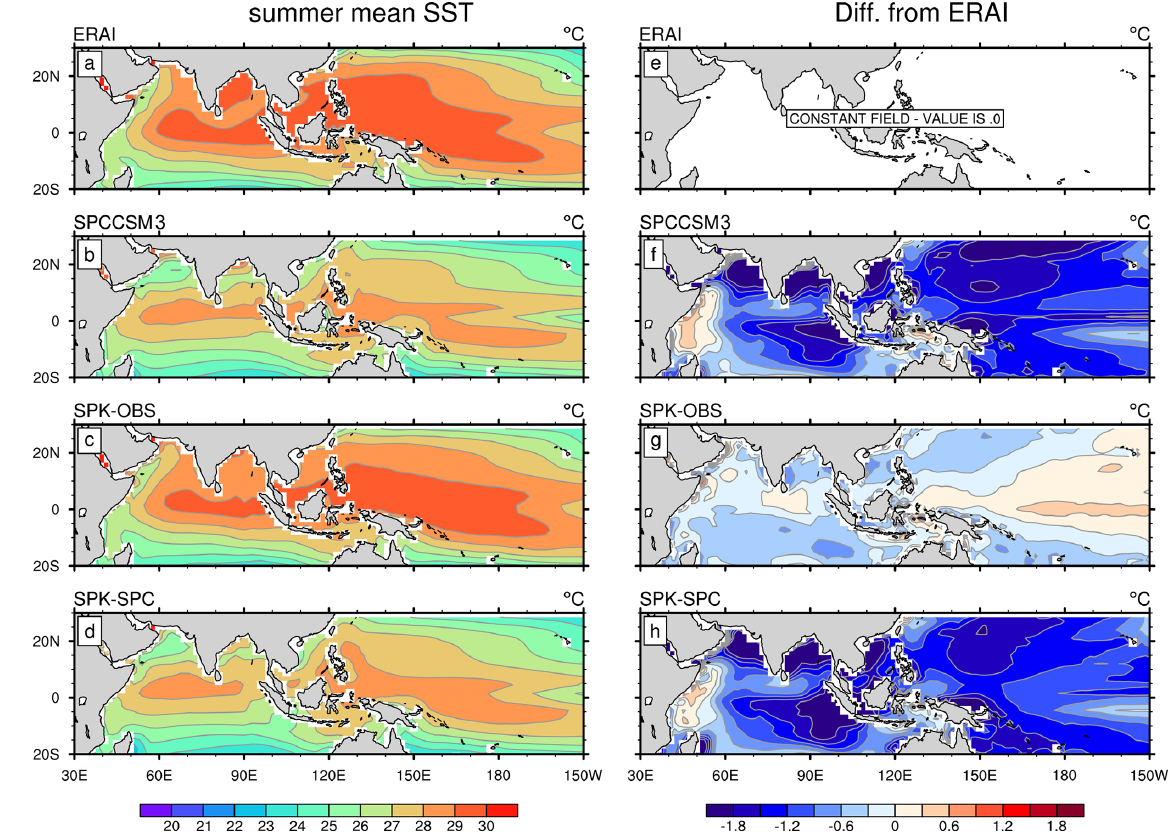
Figure 1. May–October mean SST for (a) ERAI, (b) SPCCSM3, (c) SPK-OBS, and (d) SPK-SPC. Panels (f–h) are calculated differences between (b–d) and (a) . Table 1. List of simulations analysed in this study, including the experiment name, model, ocean climatology condition used by the model to constrain (coupled model) or as forcing (atmospheric-only model), and design